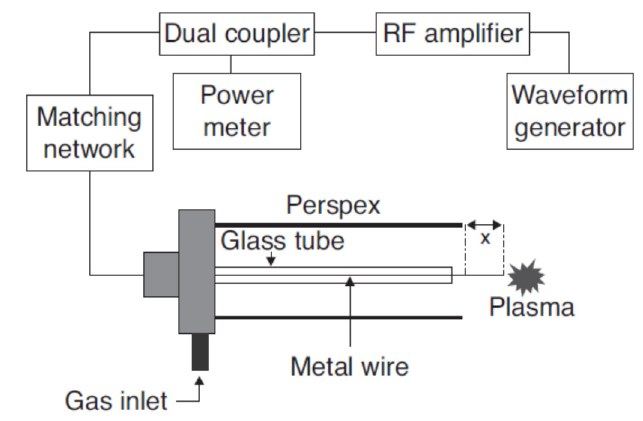
Figure 3. Plasma needle [25] .